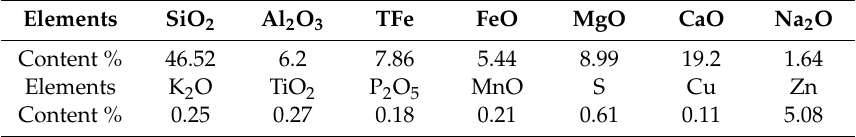
Table 2. Mineralogical composition of fine tailings.